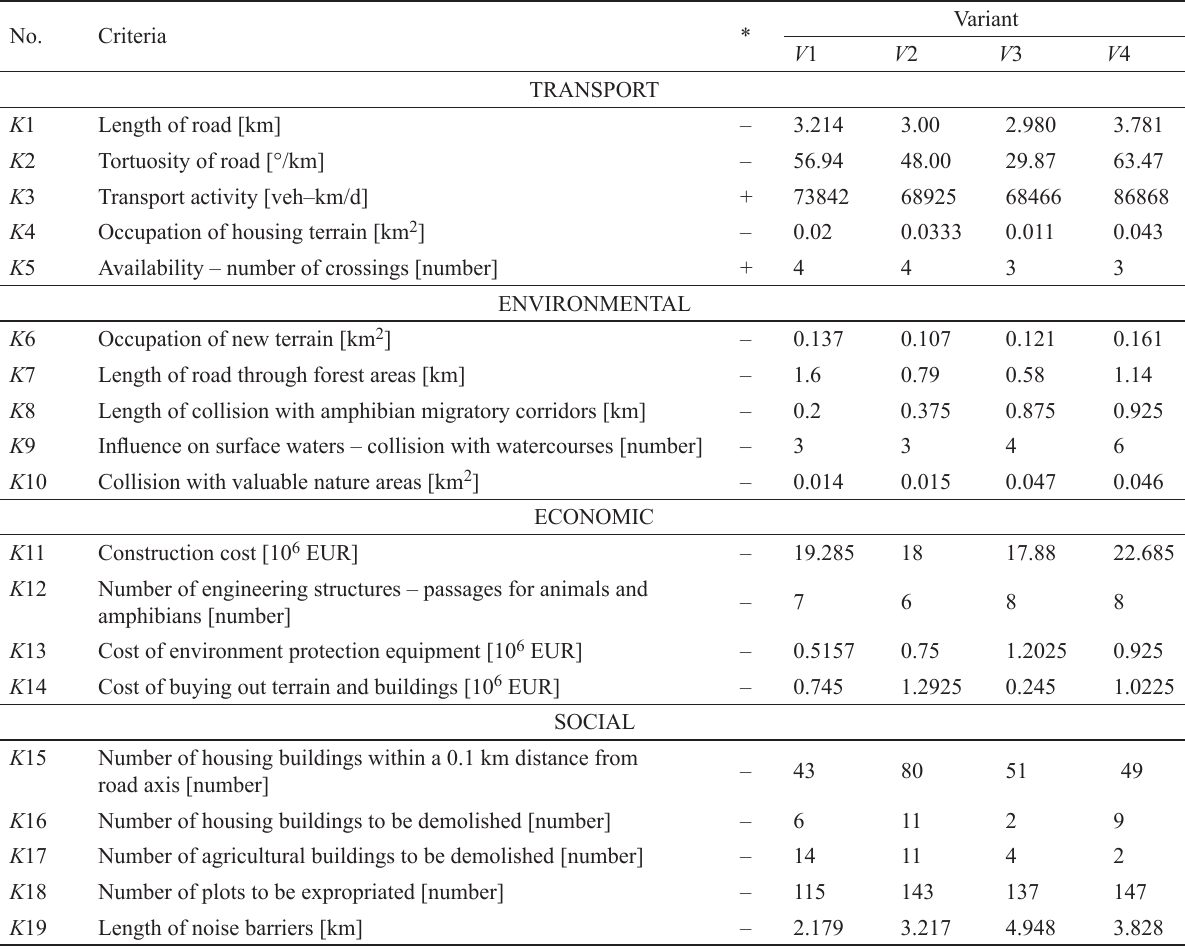
Table 2. Description of road alignment variants